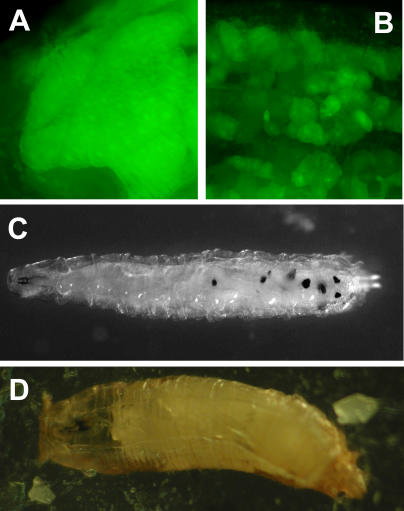
adgf-a Mutant Phenotype(A and B) Fat body disintegration visualized by GFP expression driven by Cg-Gal4 driver in the fat body. While adgf-a/+ heterozygous third instar larvae have normal flat layers of fat body (A),adgf-a mutant showed extensive fat body disintegration into small pieces of tissue (B).(C) Multiple melanotic tumors present in adgf-a mutant third-instar larva.(D) An adgf-a mutant pupa with typical abdominal curvature.